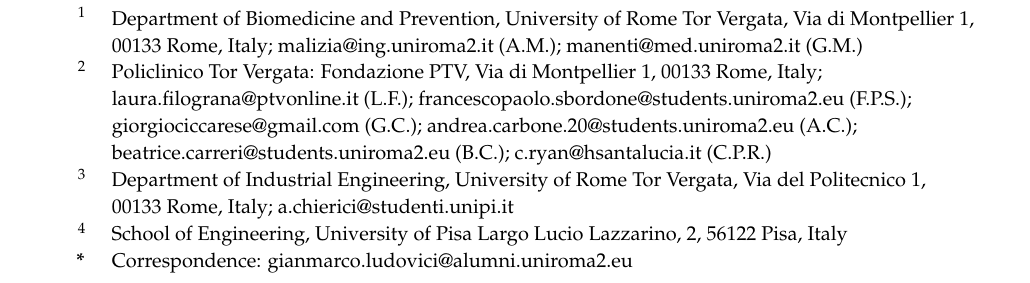
Figure 1: This image refers to the University. We cannot publish an image of the